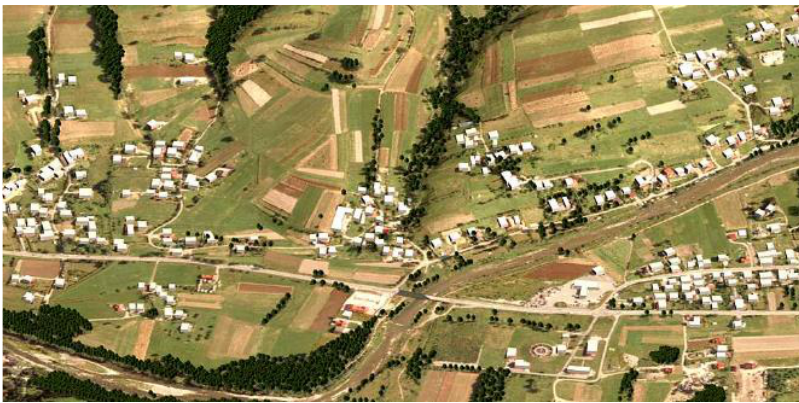
Figure 15. Digital terrain surface model — Kasinka Mala.